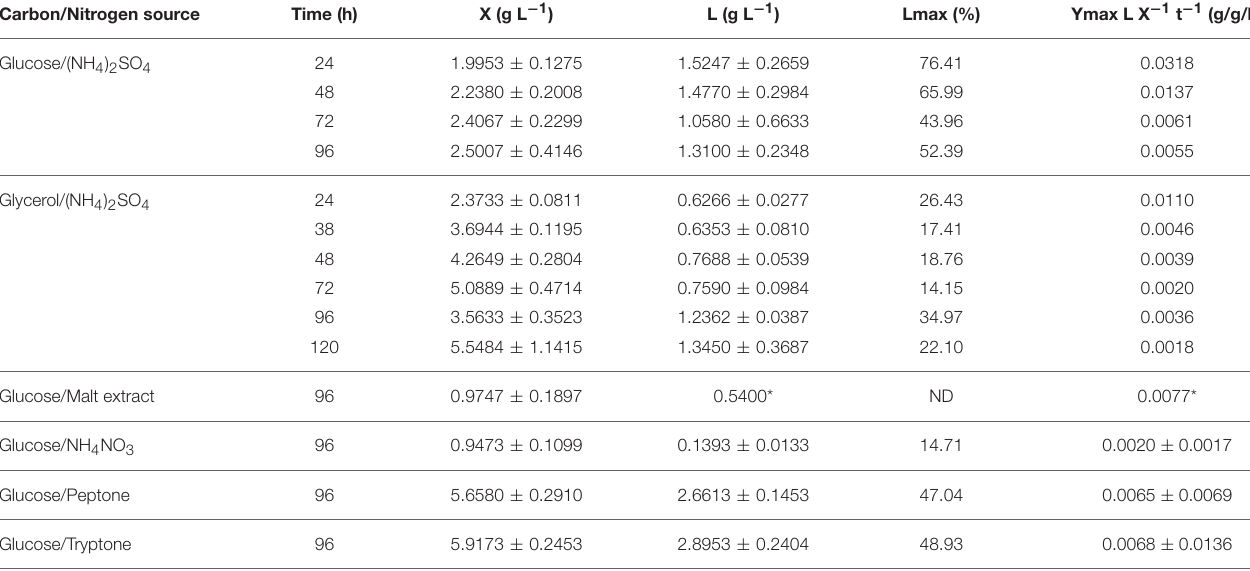
TABLE 2 | Meyerozyma guilliermondii BI281 growth at six different combinations of carbon or nitrogen sources. Carbon/Nitrogen source